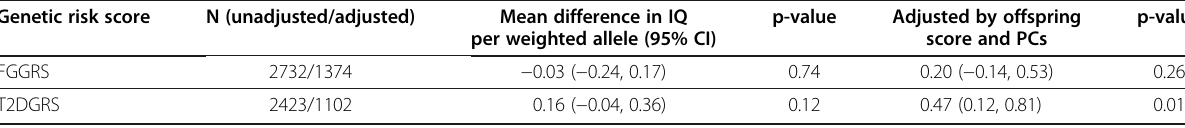
FGGRS = fasting glucose genetic risk score. T2DGRS = type 2 diabetes genetic risk score. PCs = population stratification principal